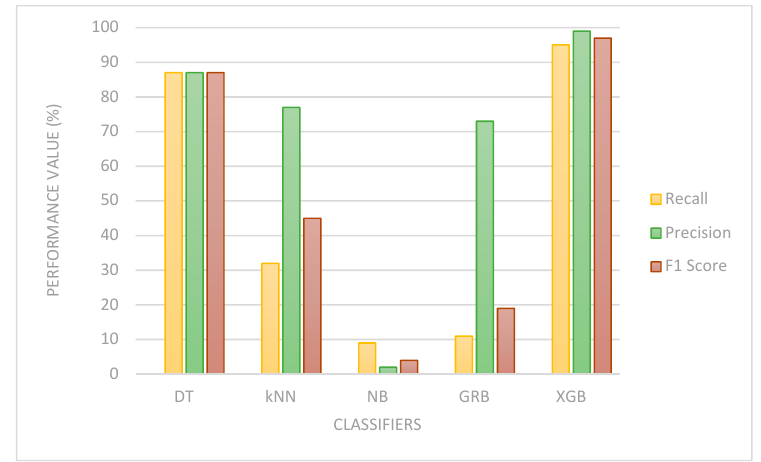
Figure 9. Performance for normal instances classification in binary classification.